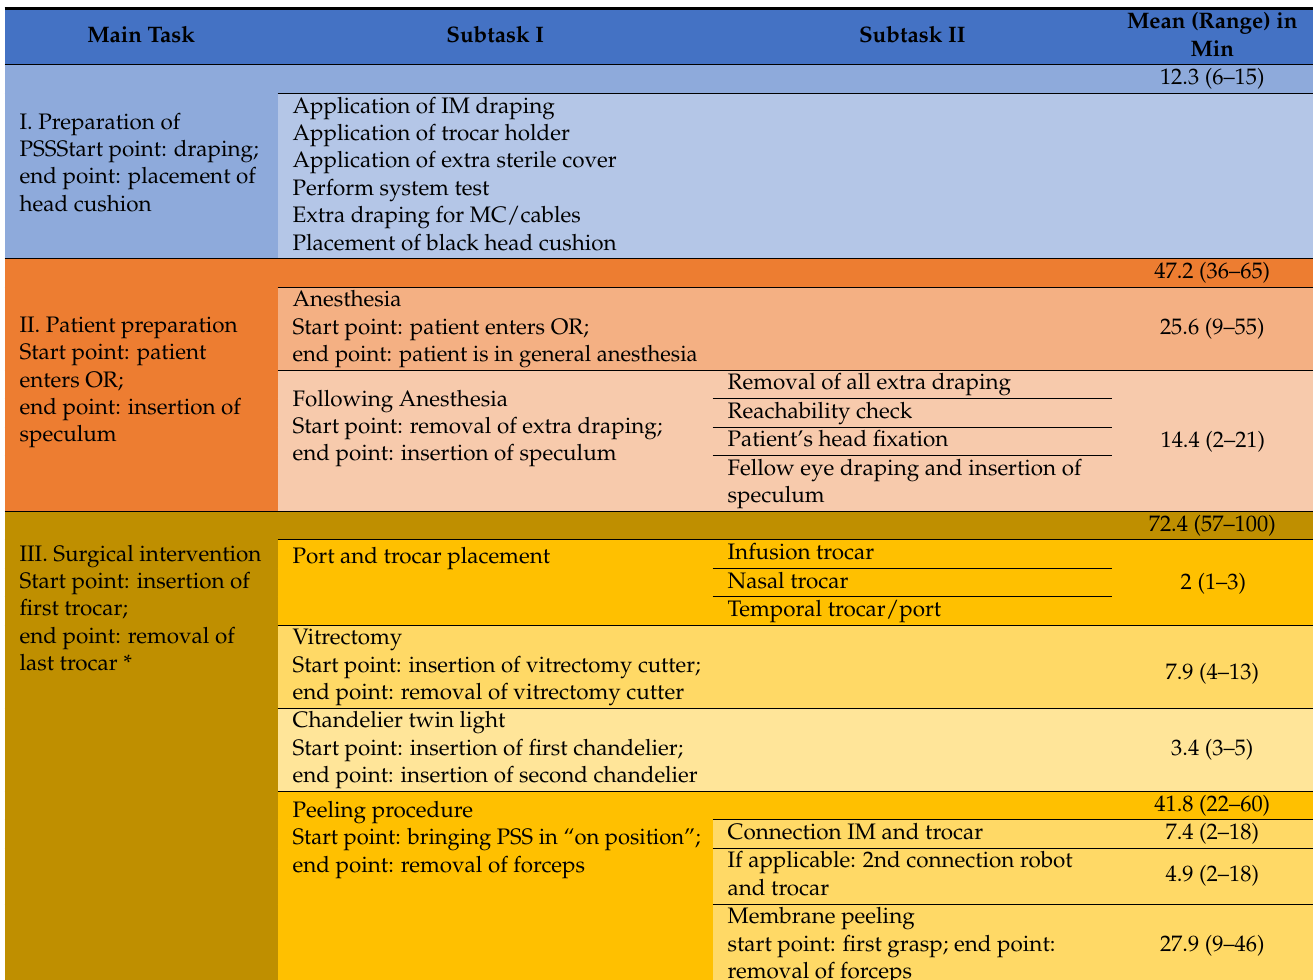
Table 3. The mean times with ranges required for the three main tasks and the associated subtasks. * In case of combined surgery, the time needed for cataract surgery was